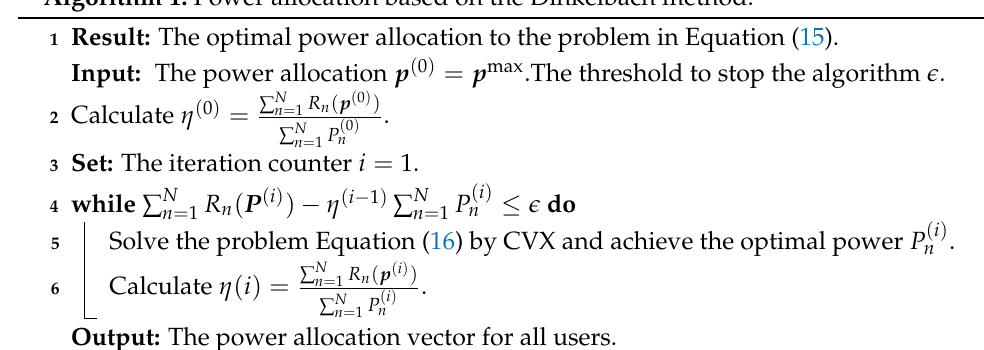
Algorithm 1: Power allocation based on the Dinkelbach